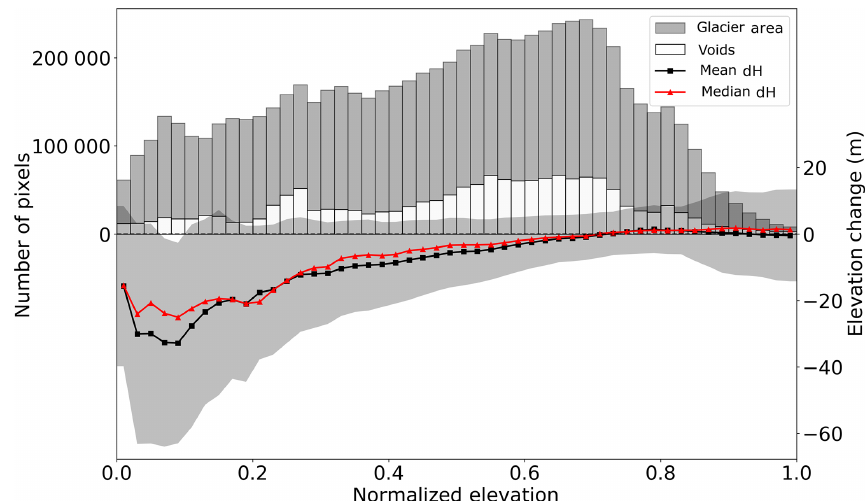
Figure 3. Distribution of glacier area and voids by normalized elevation (0 – lowest elevation, 1 – highest elevation), and mean and median elevation changes by normalized elevation, binned using bin widths of 0.02. The shaded area around the mean elevation changes indicates the mean ± 1 standard deviation.